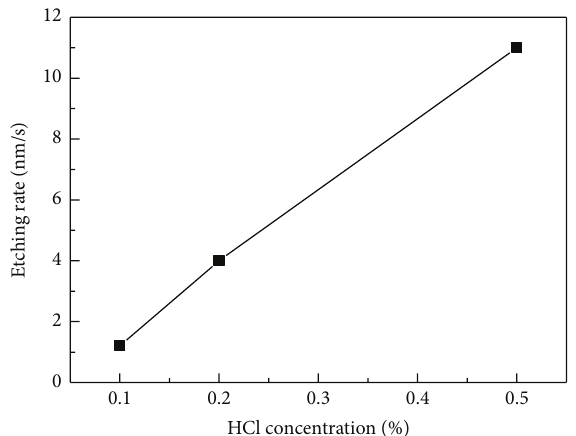
Figure 4: Etching rate of the FZO thin films as a function of HCl solution concentration.